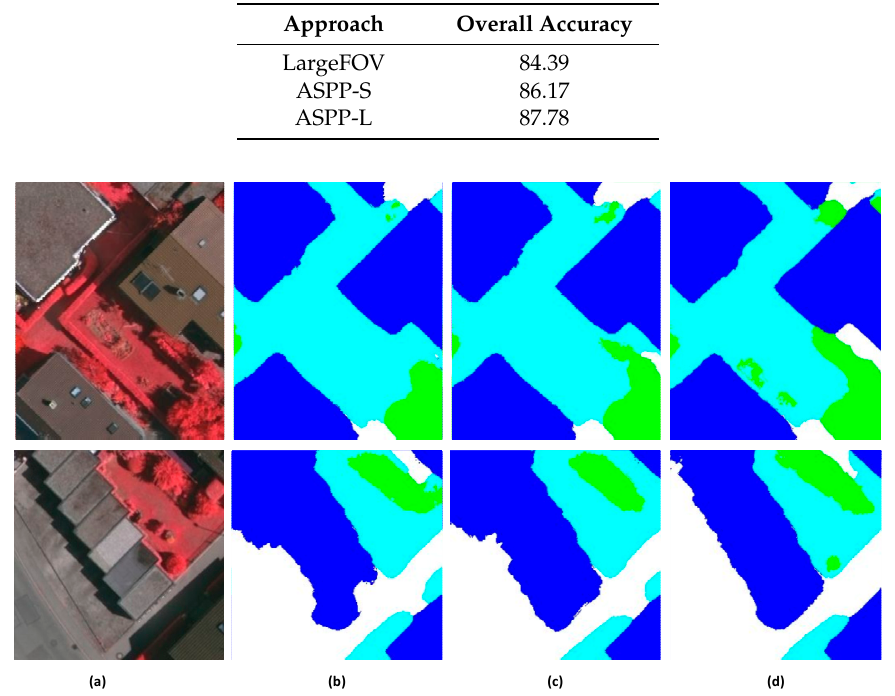
Figure 11. ( a ) Original images; ( b ) LargeFOV; ( c ) ASPP-S, with four branches and smaller atrous rates ( r = 2, 4, 8, 12); ( d ) ASPP-L, with four branches and larger atrous rates ( r = 6, 12, 18, 24).